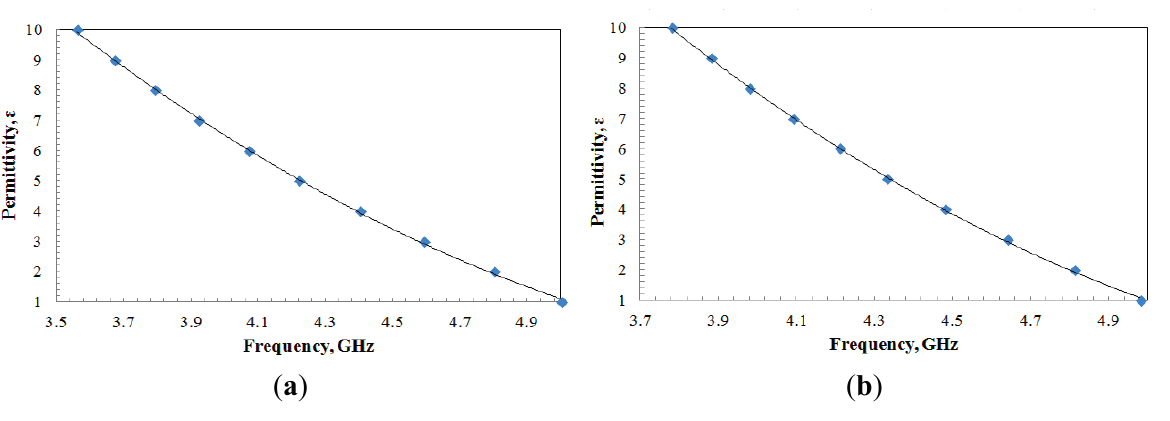
Figure 8. Sample permittivity as a function of resonance frequency for ( a ) aligned-gap multi-ring; ( b ) centered-gap sensor.